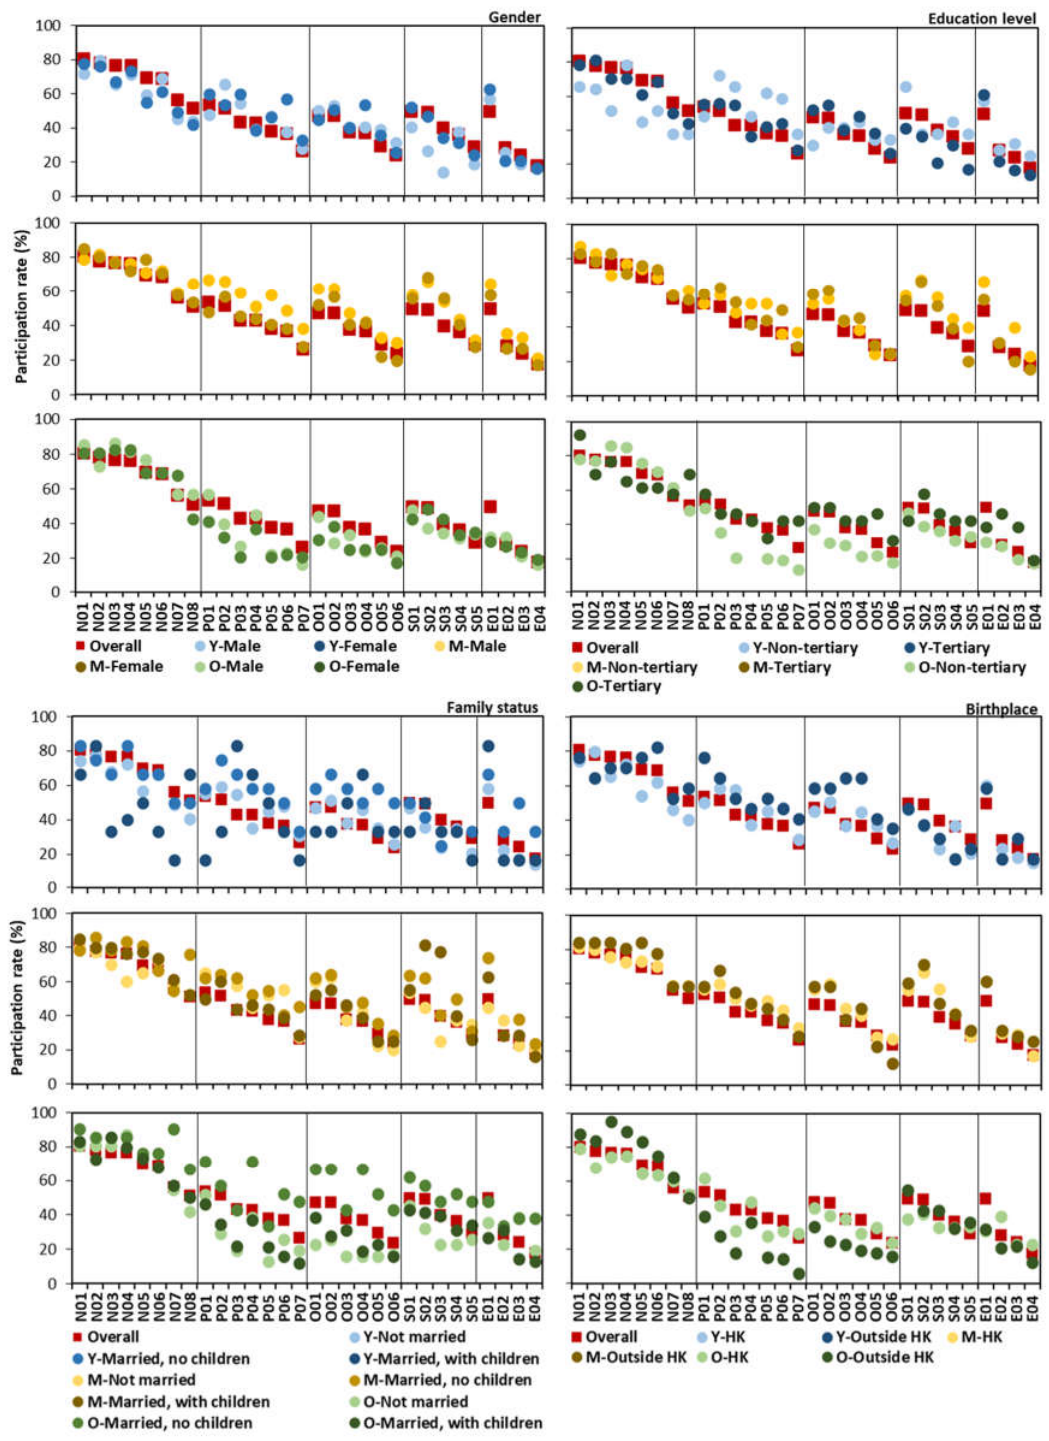
Figure 5. The participation rate (%) in 30 activity types with reference to the socio-economic factors of gender, education level, family status, and birthplace by three age sectors. Note. Refer to Table 3 for the codes of the activity types.